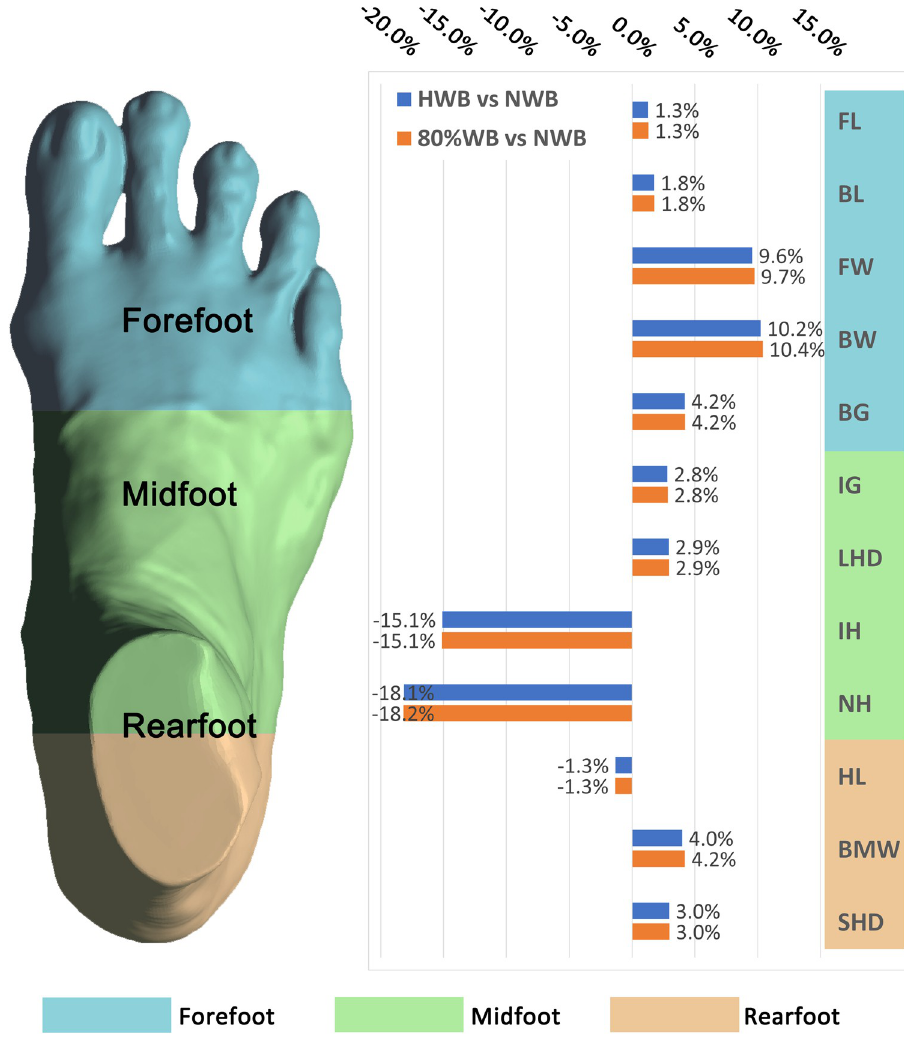
Fig 6. Percentage change of foot measurements.